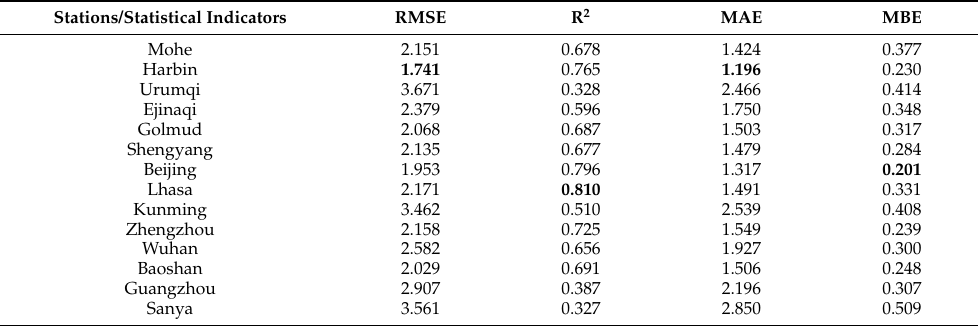
Table 5. Statistical results of R d _s obtained by Himawari-7 satellite and R d obtained by ground weather